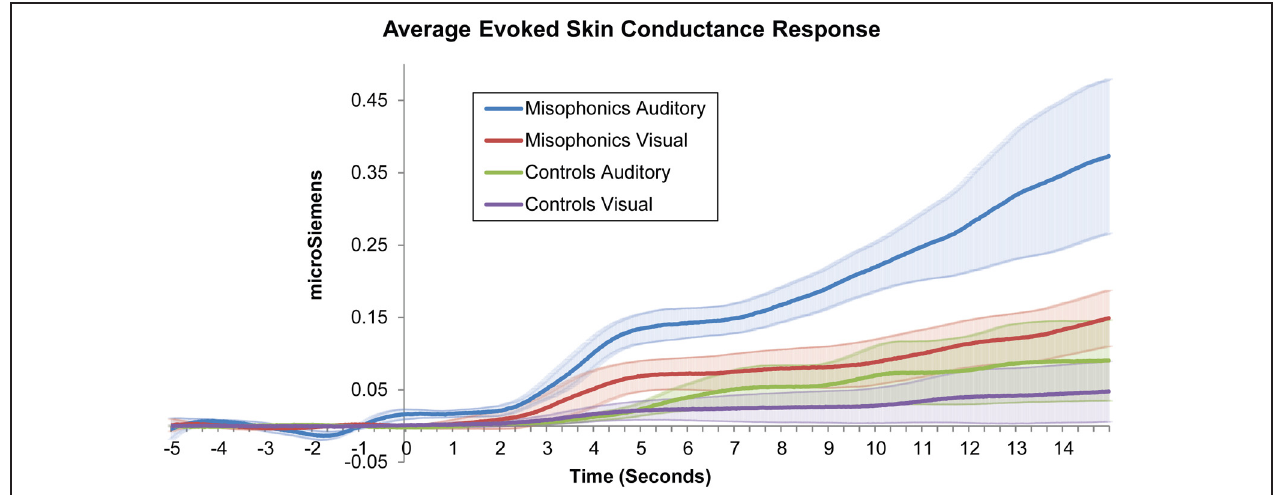
FIGURE 1 | Average misophonic and control participants’ skin conductance response to auditory and visual stimuli as a function of